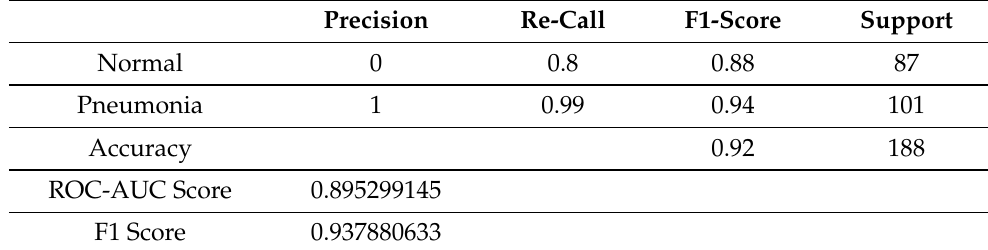
Table 3. Result analysis of the Xcpetion